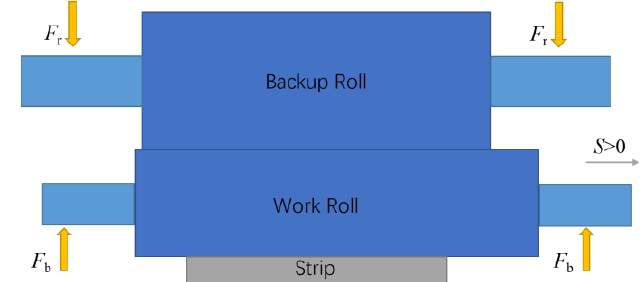
Figure 1. Layout of CVC mill.